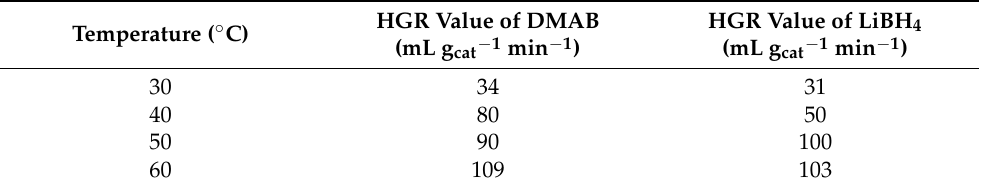
Table 3. HGR values with nickel catalyst at different temperatures.